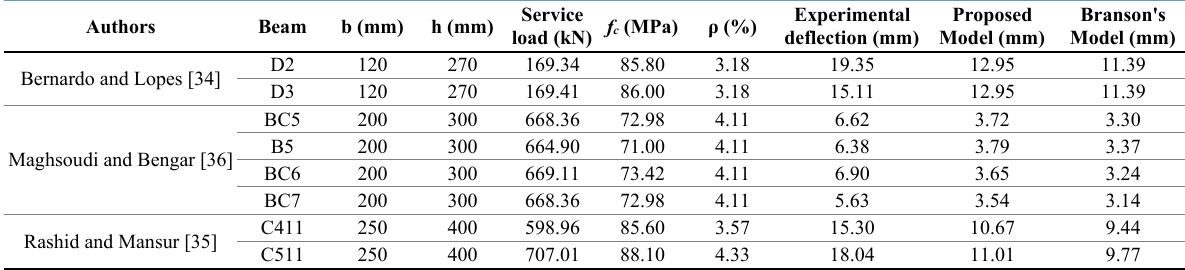
Table A6. Beams data with f c from 50MPa to 90MPa and reinforcement rate greater than